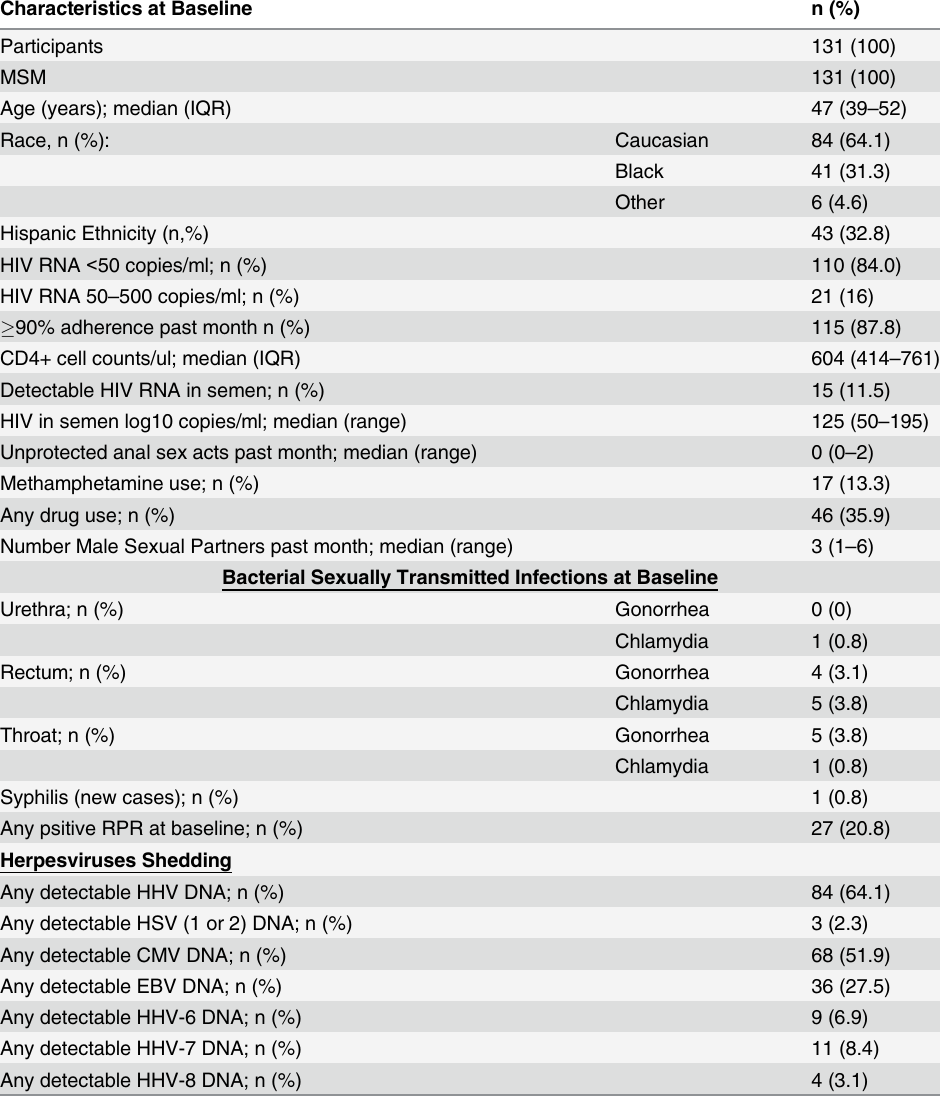
Table 1. Demographics and co-infections at baseline. Characteristics at